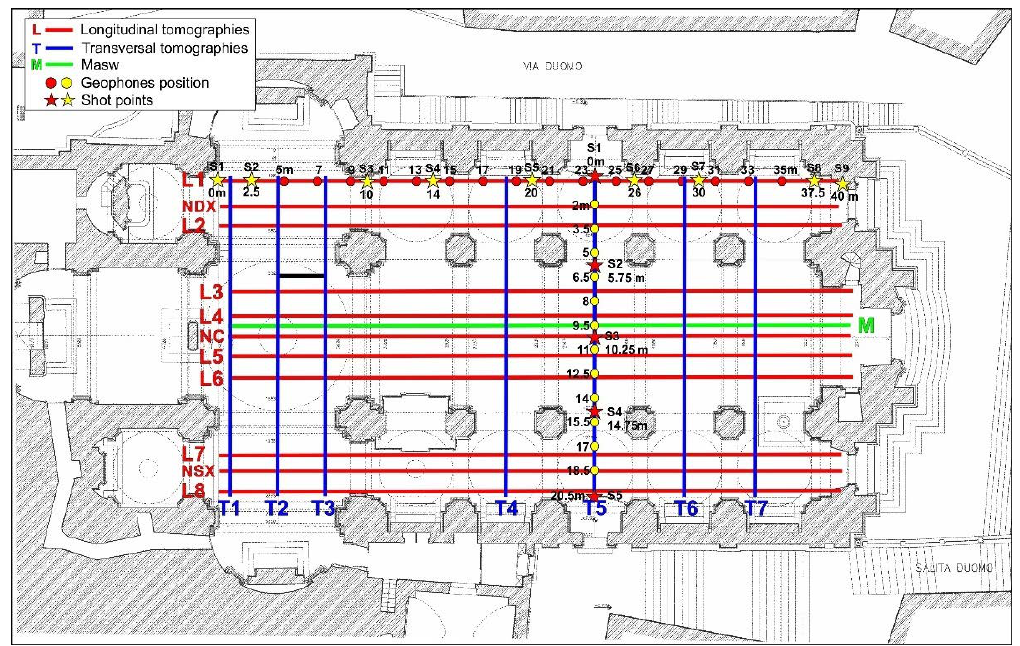
Figure 6. Seismic tomographies and MASW acquisition schemes.